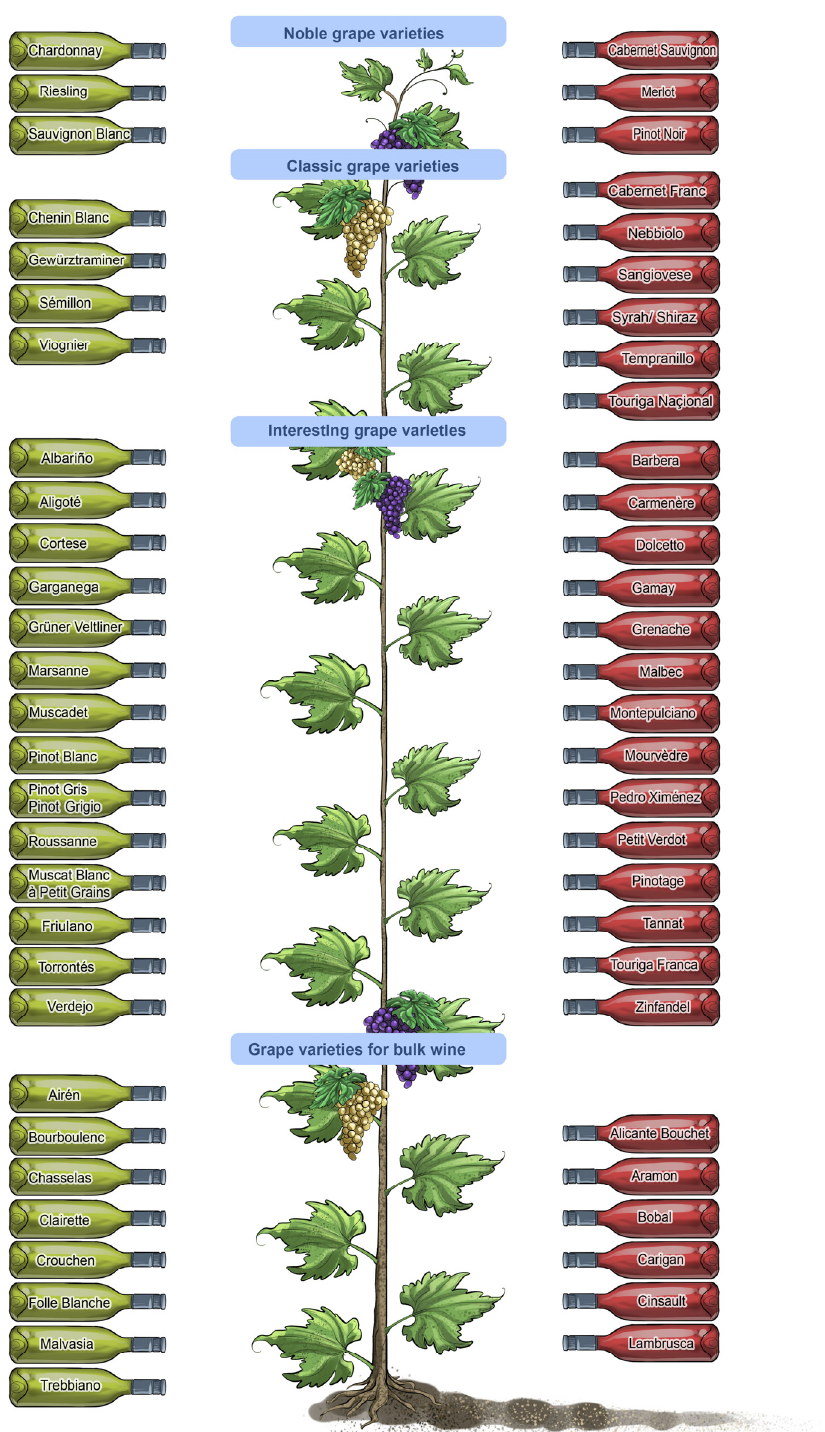
Figure 5. The quality tree of grape cultivars and varietal wines (adapted from [8]). In most consumer markets, the ‘Big Six’ varieties—Cabernet Sauvignon, Merlot, Pinot Noir, Chardonnay, Riesling and Sauvignon Blanc—are regarded as ‘noble’ varieties from which the most sought-after varietal wines are made. One level down are the so-called ‘classic’ grape cultivars which include the red varieties, Cabernet Franc, Nebbiolo, Sangiovese, Syrah (or Shiraz), Tempranillo and Touriga Naçional and the white varieties, Chenin Blanc, Gewürztraminer, Semillon and Viognier. The category below the latter cultivars are generally referred to as ‘interesting’ varieties and there is a long list of them. The image and brand-strength of some of these so-called ‘interesting’ cultivars are strongly linked to specific wine producing countries and regions, for example, Italian Barbera, Chilean Carmenére, Argentinian Malbec, South African Pinotage, Uruguayan Tannat and Californian Zinfandel.